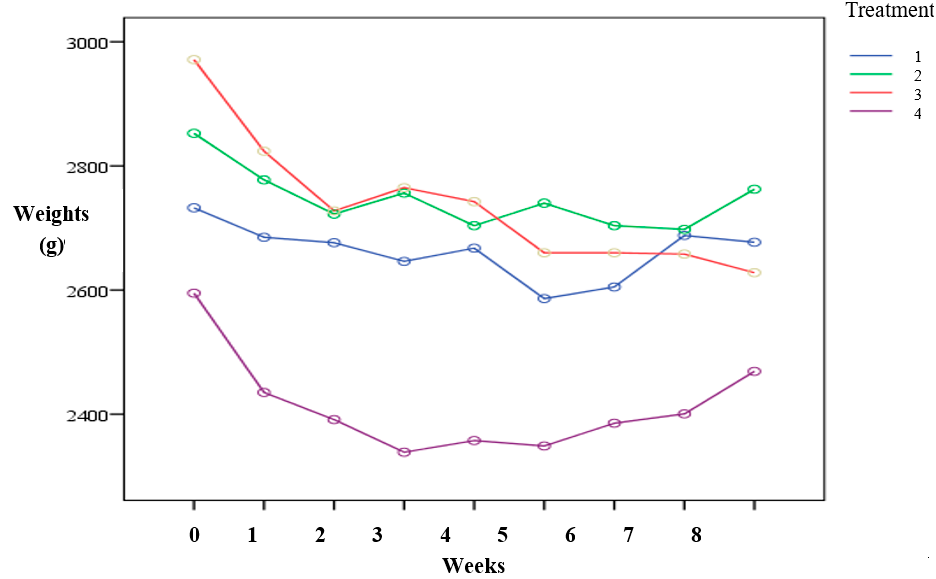
Figure 1. The average weights of each treatment over the 8-week period.